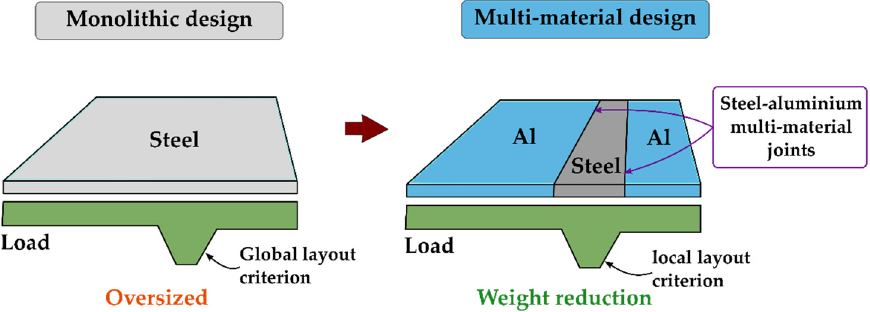
Figure 4. Example of a multi-material design using welding process.